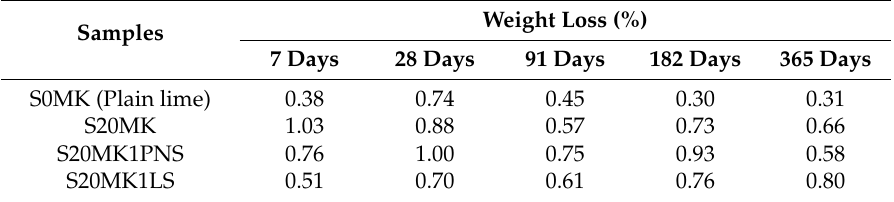
Table 4. TG results of weight loss between 25–300 ◦ C, assigned to dehydration of pozzolanic